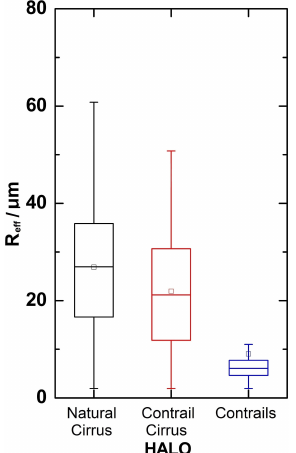
Figure 5. R eff of natural cirrus, contrail cirrus and contrails from HALO in situ measurements. Each bar contains the information of the maximum, minimum, interquartile range (25th percentile to 75th percentile), median (horizontal line) and mean (square) R eff